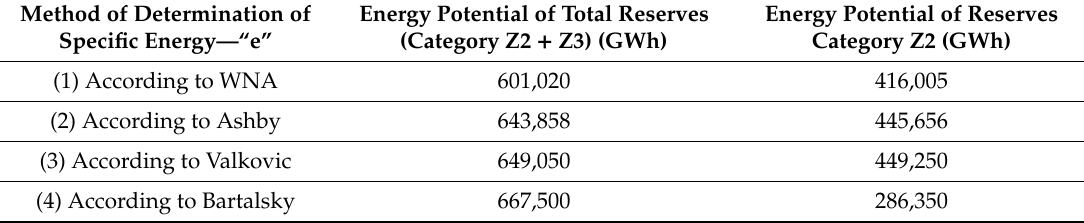
Table 6. The energy potential of reserves at the deposit of Kuriskova. Method of Determination